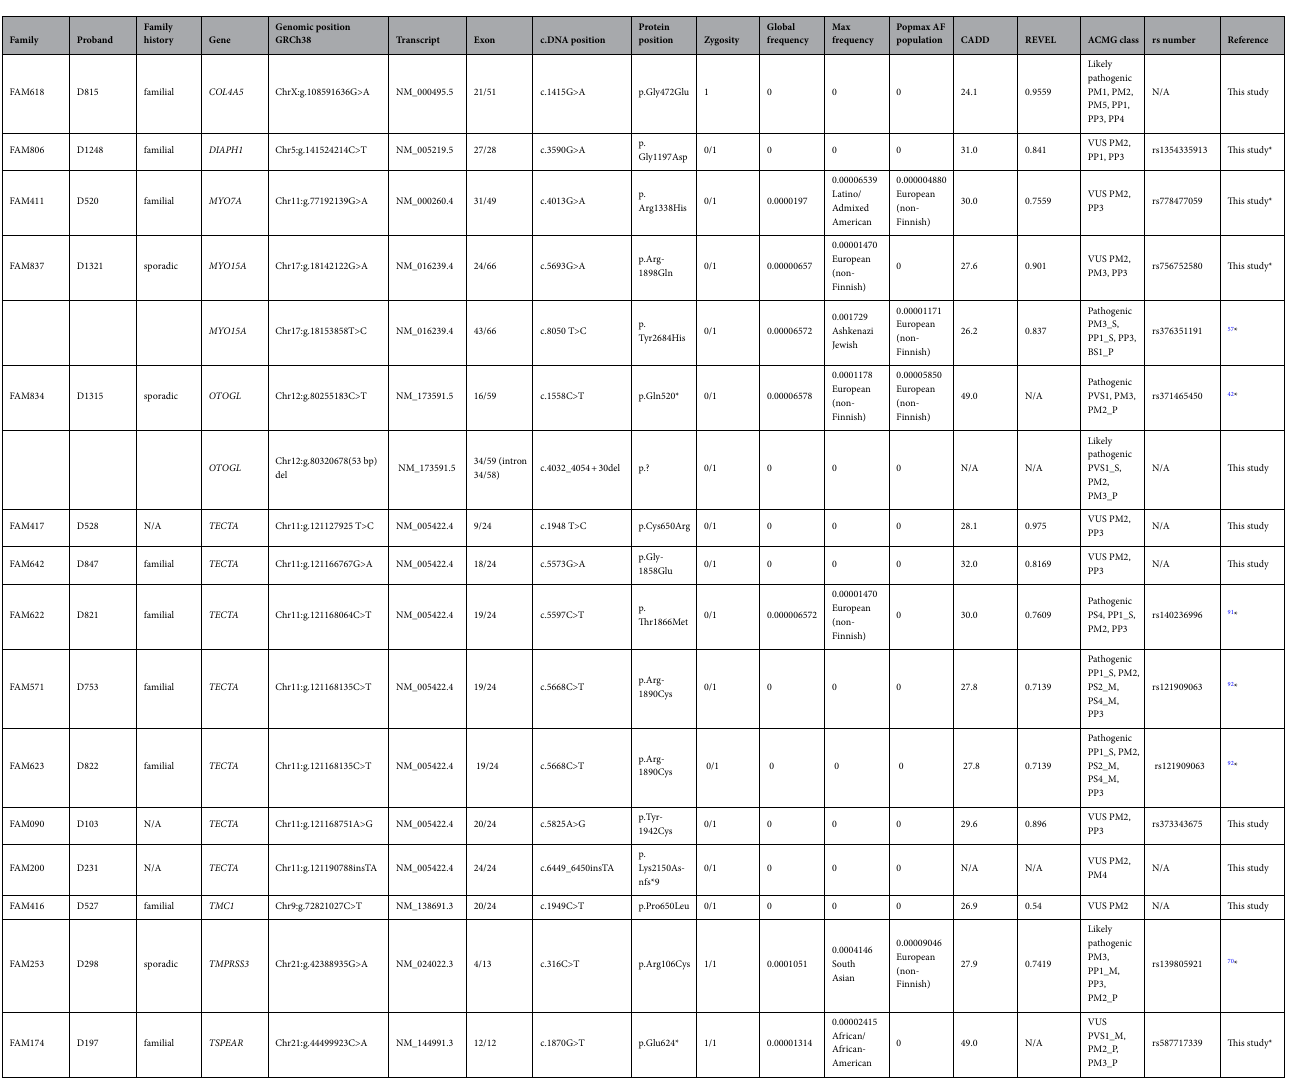
Table 2. Pathogenicity evaluation of 16 variants based on in-depth ACMG HL guideline application in 15 probands with mid-frequency SNHL. *, variant occurs in https:// deafn essva riati ondat abase. org/; _M, moderate; _P, supporting; _S, strong; N/A, not available; VUS, variants of uncertain